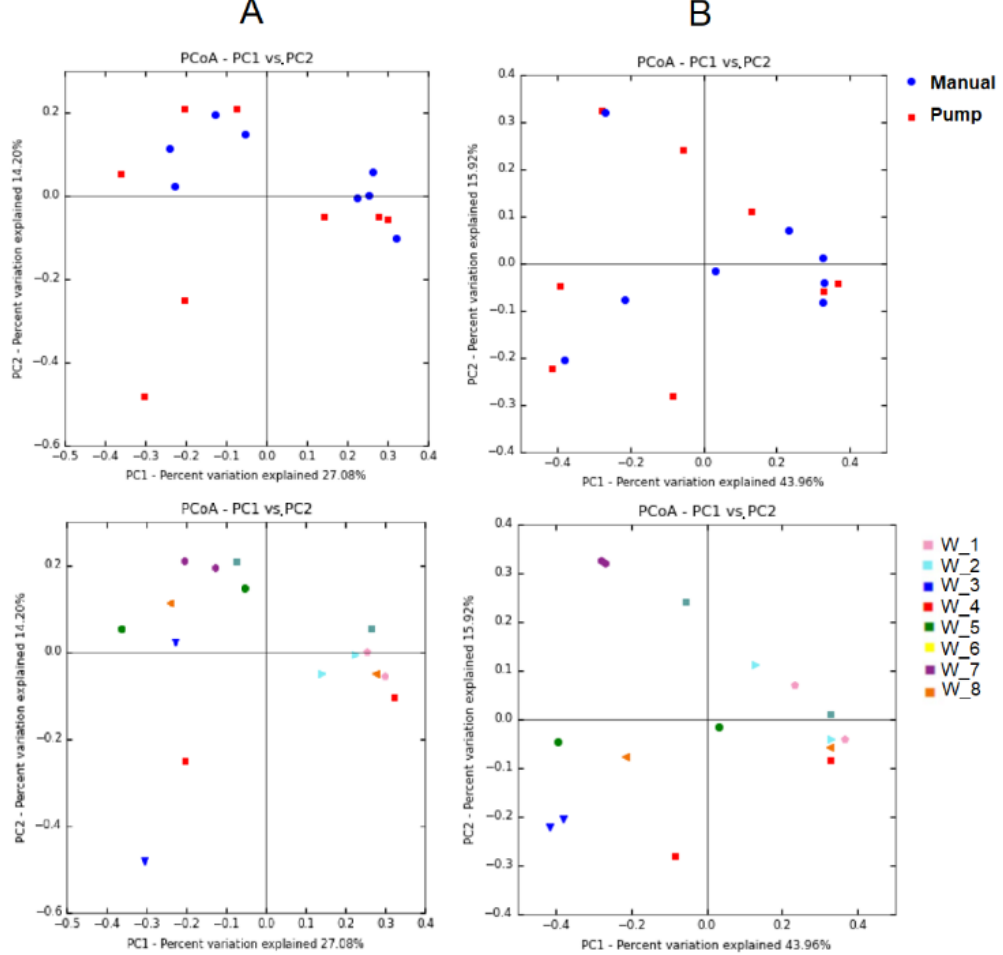
Figure 2. PCoA plots of bacterial profiles (at operational taxonomic unit (OTU) level) based on the Jaccard’s coefficient for binary data (presence/absence) ( A ) and on the Bray–Curtis similarity analysis (relative abundance) ( B ) of the milk samples collected from women 1 to 8. The value given on each axis label represents the percentage of the total variance explained by that axis. In the upper figures, color and shape of the symbol indicate the collection method (red squares, pump using a single-use device; blue circles, manual expression). In the bottom figures, different colors of the symbols represent the samples provided by each woman, independently of the collection method.